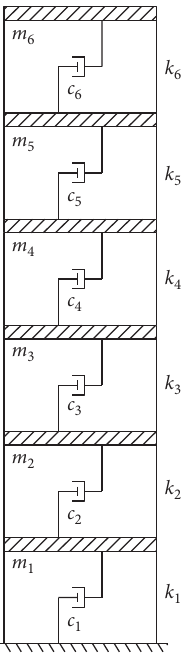
Figure 13: Six-story shearing frame model with VFDs. Table 2: Information on the considered earthquake